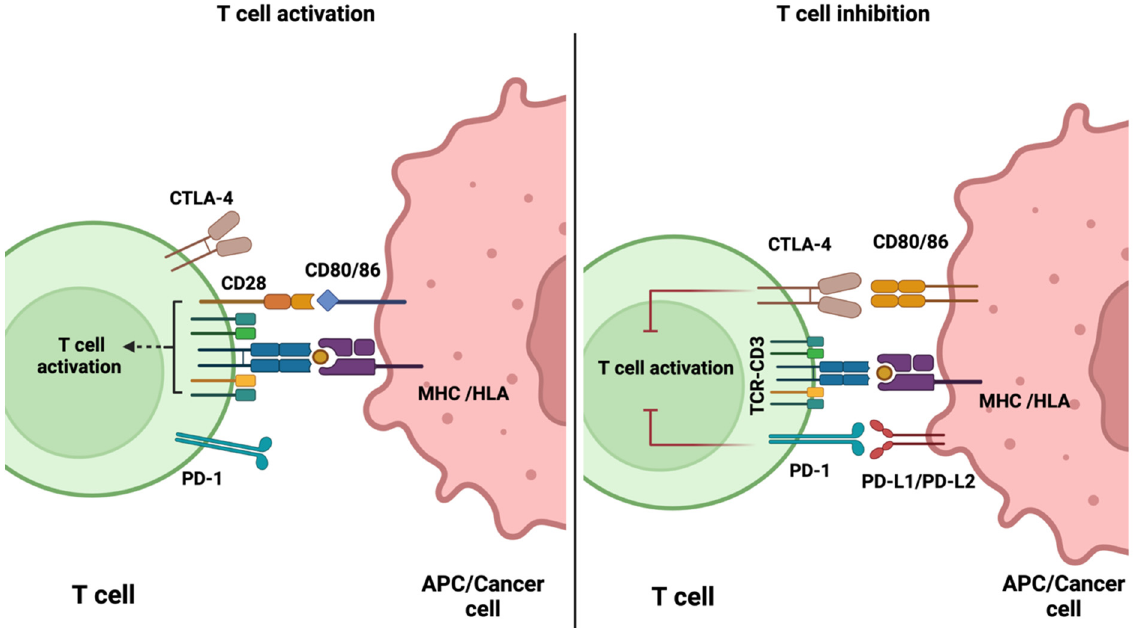
Figure 1. Schematic diagram demonstrating the role of immune checkpoint molecules in the regula- tion of activated T cells. Diagram was generated using BioRender.com (accessed on 17 August